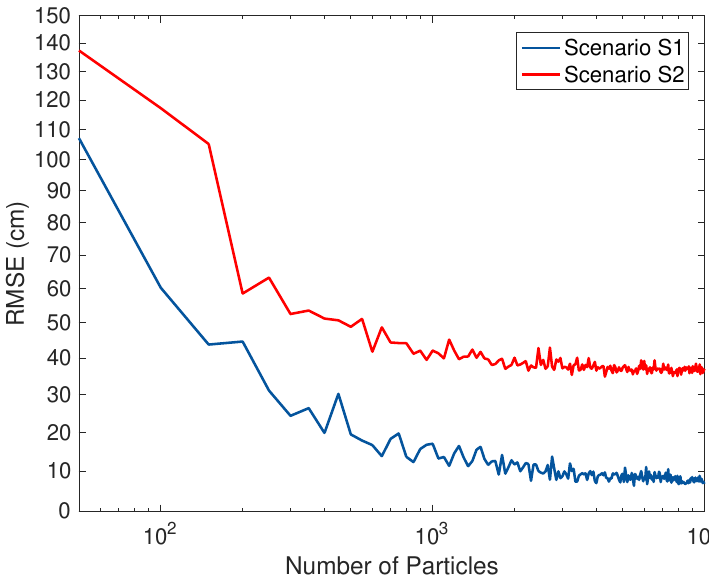
Figure 15. RMSE value between the estimated location by PF and its corresponding actual position versus the number of particles for PF in Scenarios S1 and